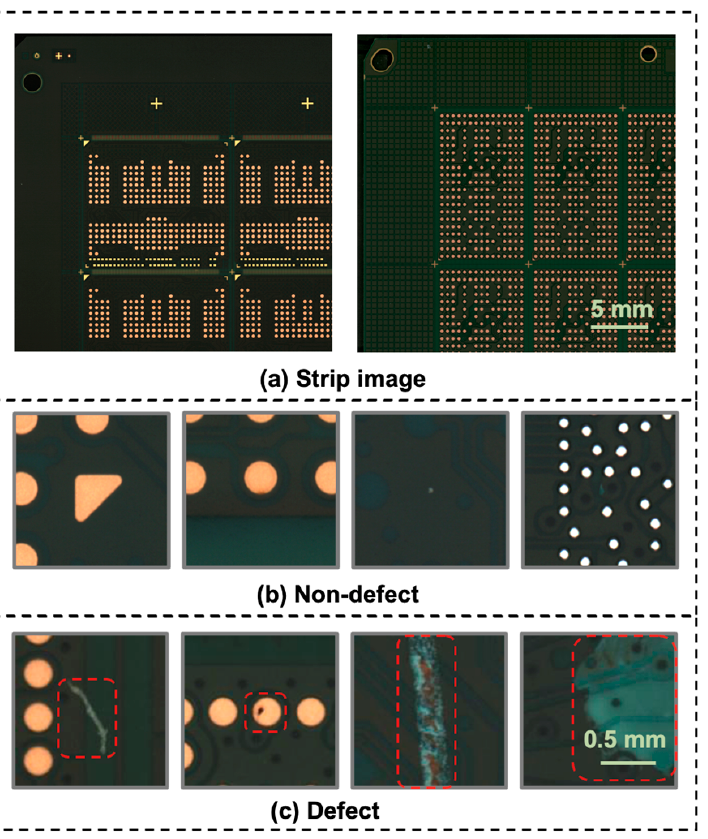
Figure 1. Examples of ( a ) strip-level PCB images and ( b ) non-defect and ( c ) defect images acquired by the AFVI system: the red dashed boxes in ( c ) represent the defect locations on the circuit board.